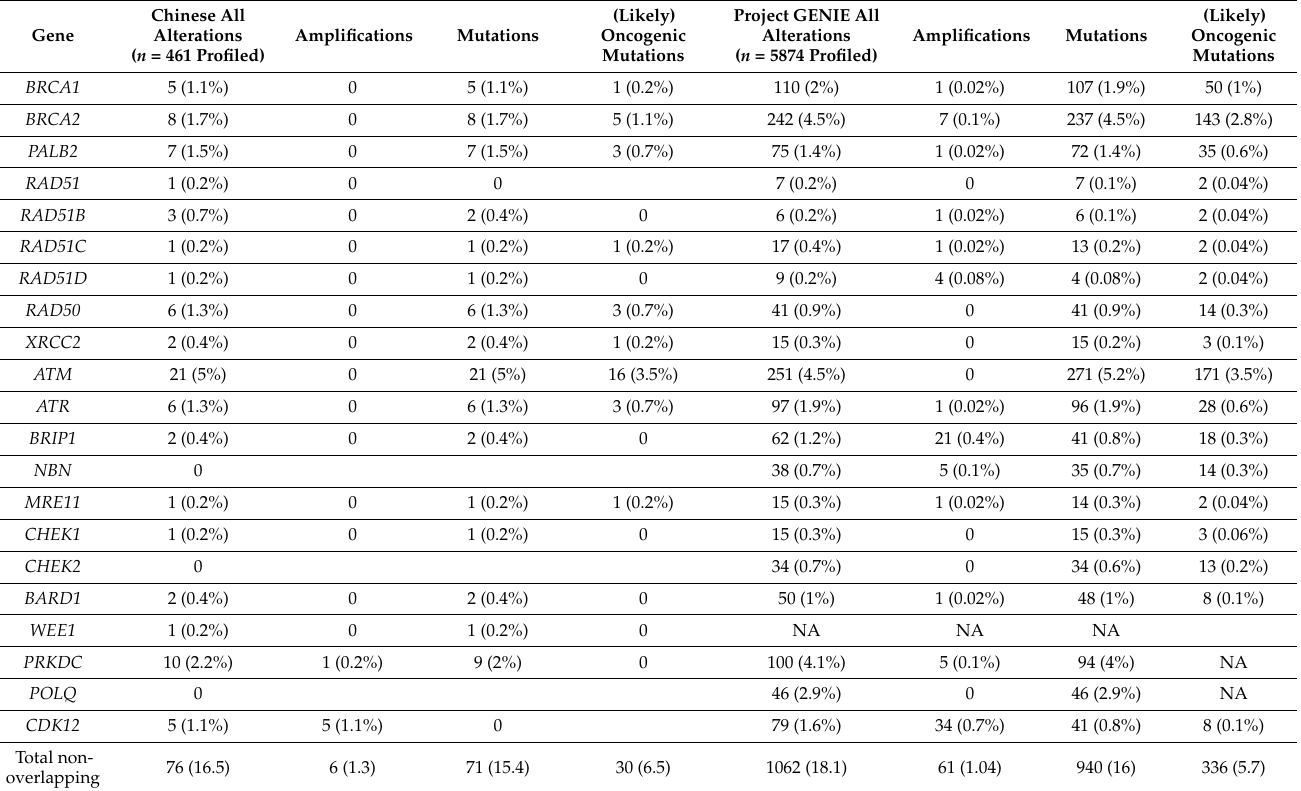
Table 2. Alterations in DDR-related genes in pancreatic cancers from Chinese Origene and project GENIE pancreatic cancer cohorts. NA: not